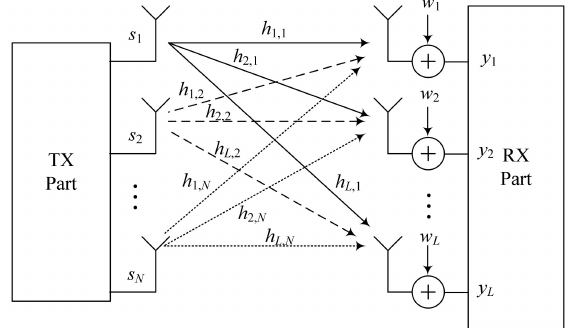
Figure 1. Structure of multiple input multiple output (MIMO) systems with N transmit (TX) and L receive (RX)